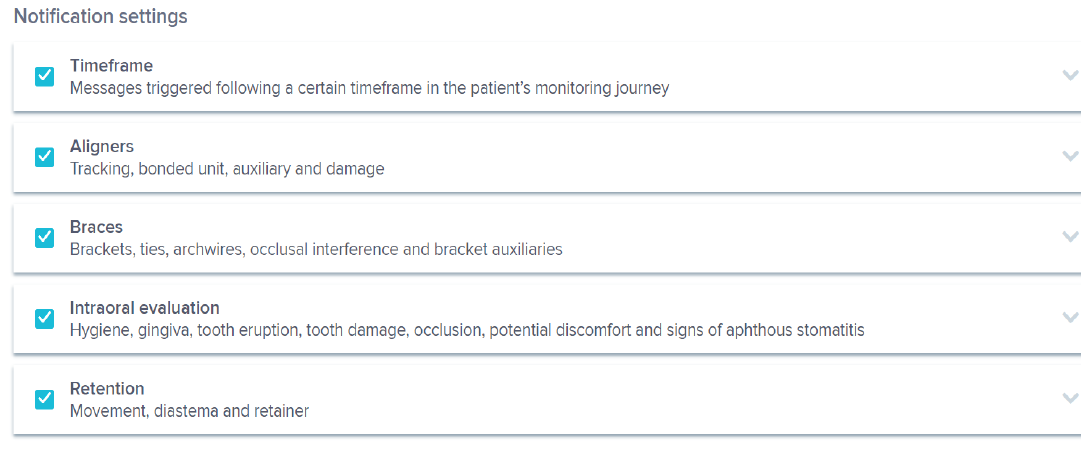
Figure 4. Notification settings in a DM system protocol.